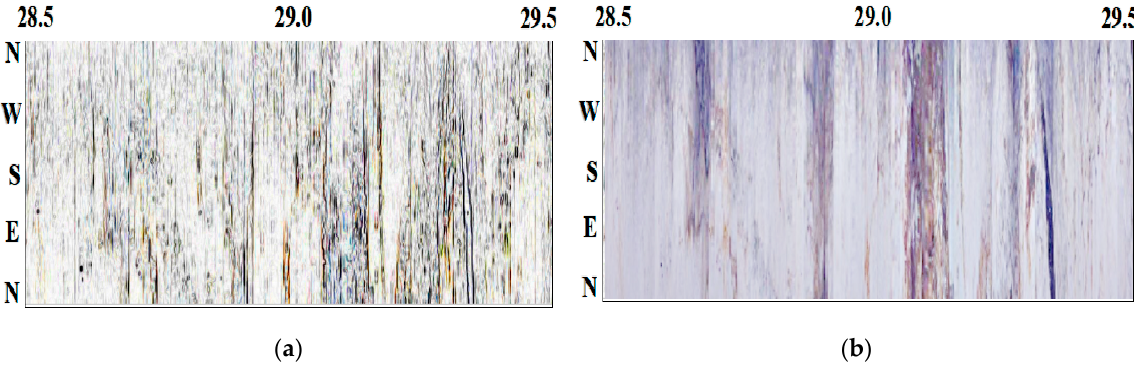
Figure 10. Rock wall optical image characteristics. ( a ) Hole wall texture feature image, ( b ) hole wall integrity feature image.